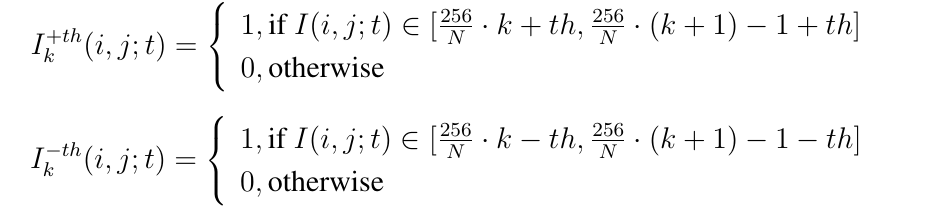
( i; j ; t ) , and produces k = min , S = max , 0 7